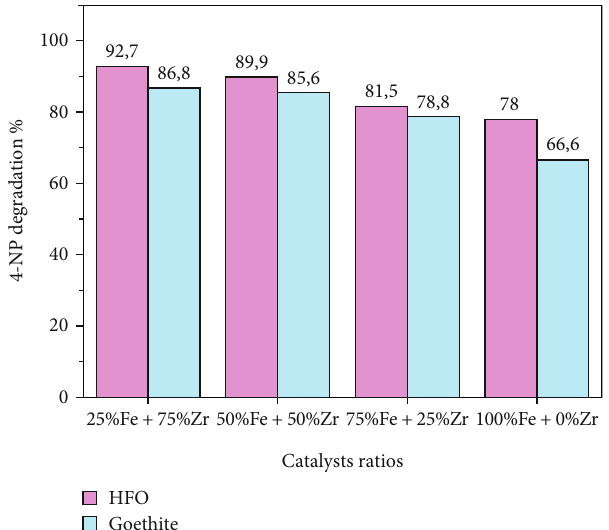
Figure 8: 4-Nitrophenol degradation e ffi cacy of tested catalysts at pH 7, 27 ° C, and 4